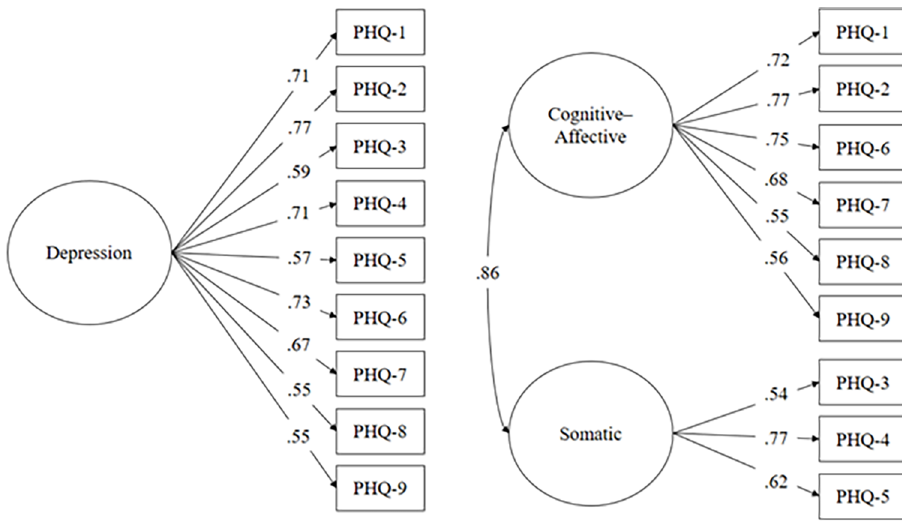
Fig 1. One-factor and two-factor models of the PHQ-9